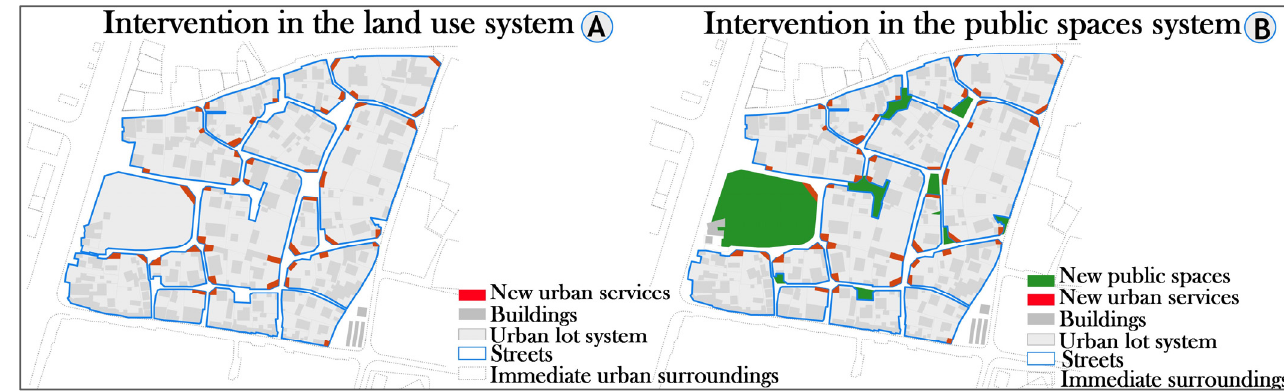
Figure 12. Activating functional diversity and the network of public micro spaces.